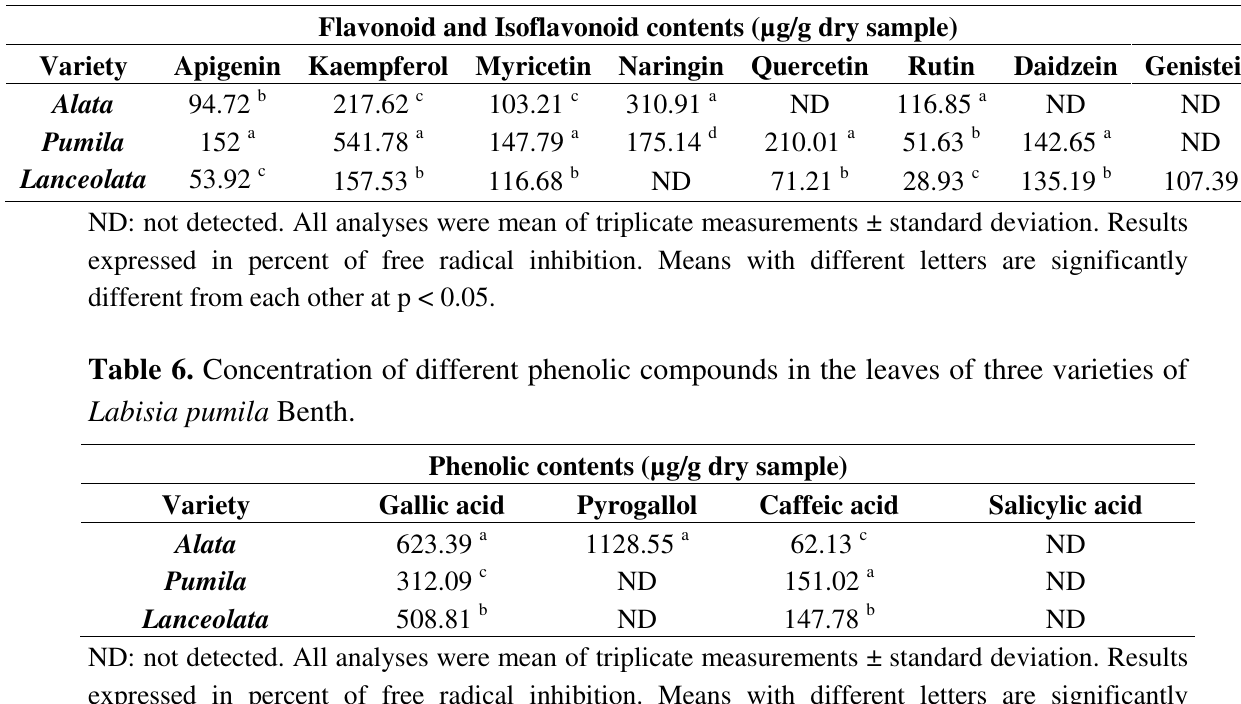
Table 5. Concentration of different flavonoids and isoflavonoids in the leaves of three varieties of Labisia pumila Benth.